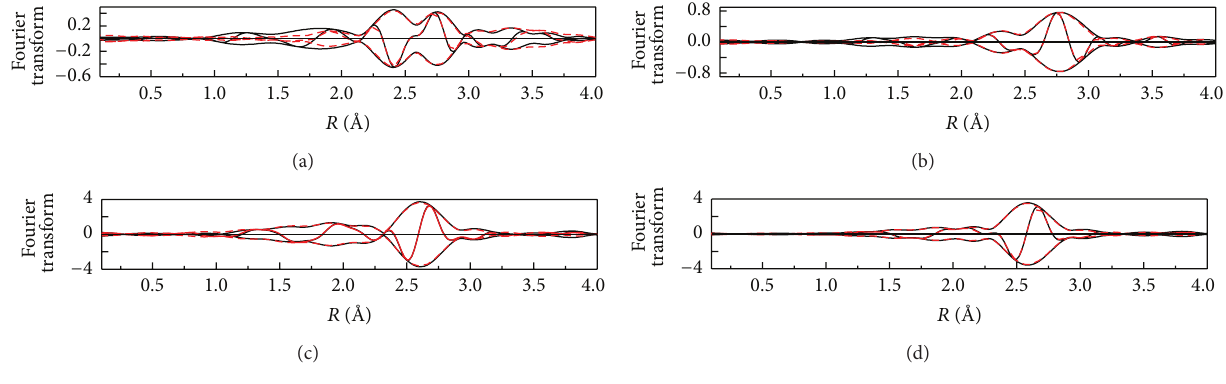
Figure 6: Comparison of imaginary part and magnitude of Fourier transform ( 𝑘 2 -weighted, 3.0 < 𝑘 < 16 ˚A corrected) of raw EXAFS data at Pt L III edge (solid line) and sum of the calculated contributions (dashed line) for (a) Pt-Ru co /C and (b) Pt-Ru se /C. Comparison of imaginary part and magnitude of Fourier transform raw EXAFS data at Ru K edge ( 𝑘 2 -weighted, 3.0 < 𝑘 < 14 ˚A Ru-Ru phase and amplitude corrected) of experimental EXAFS data (solid line) at Ru K edge and sum of the calculated contributions (dashed line) for (c) Pt-Ru co /C and (d) Pt-Ru se